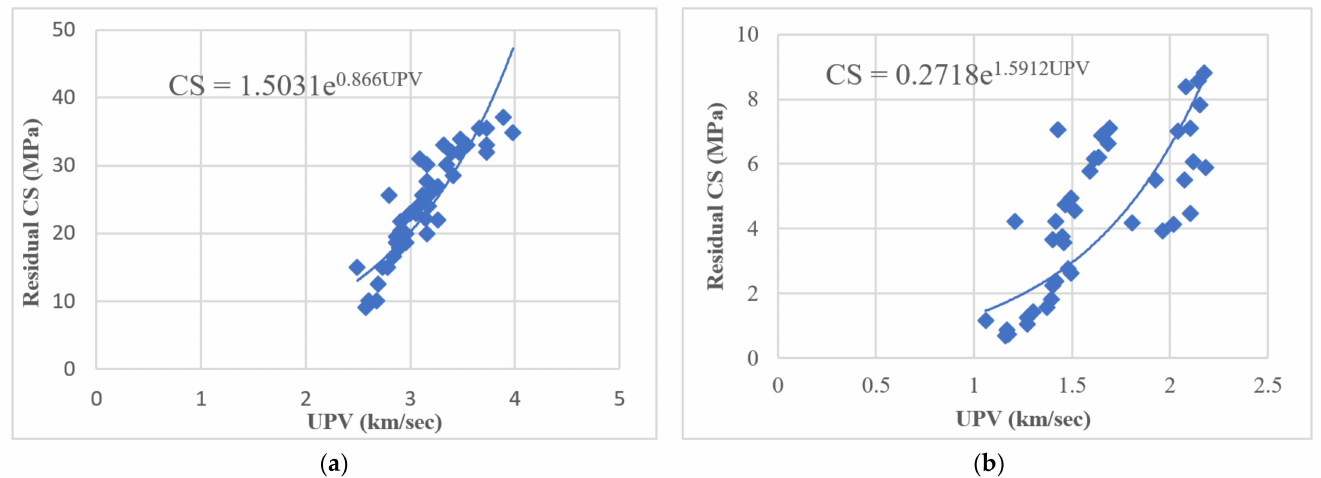
Figure 4. Relationship between UPV and residual CS for 14 studied specimens after immersion in ( a ) MgSO 4 and ( b ) H 2 SO 4